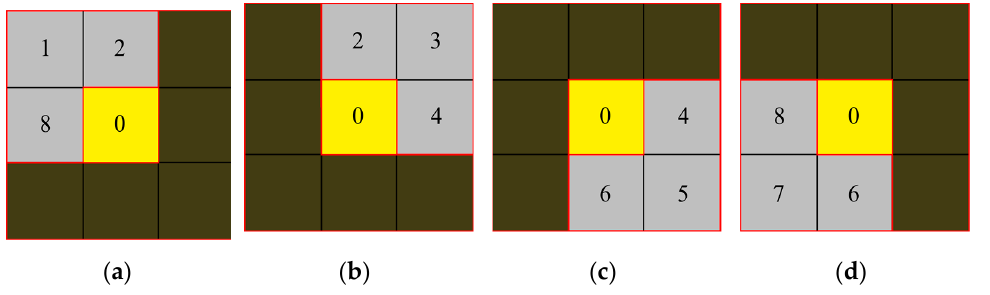
Figure 3. Newly divided into four directional blocks structure. ( a ) Upper left subblock. ( b ) Upper right subblock. ( c ) Lower right subblock. ( d ) Lower left subblock.